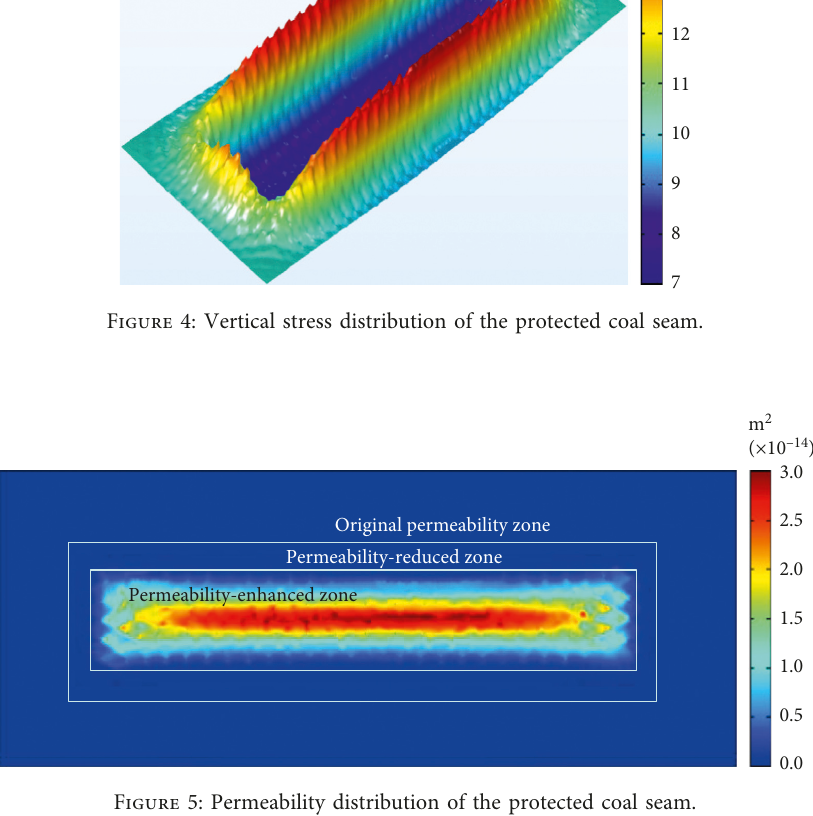
Figure 5: Permeability distribution of the protected coal seam.